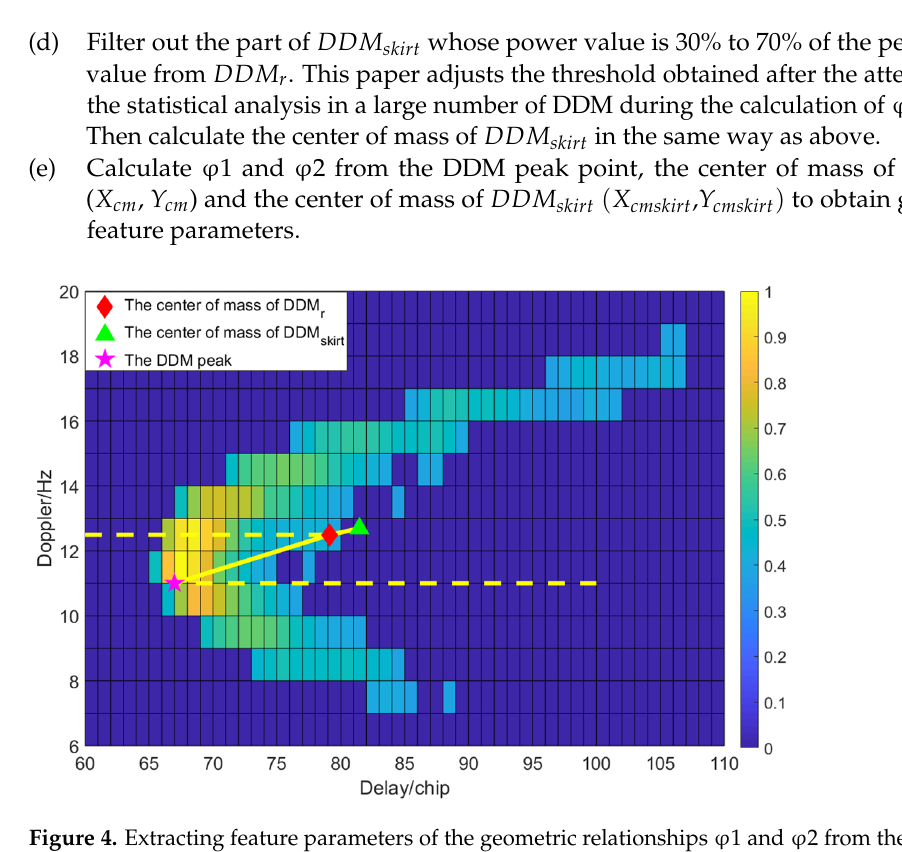
Figure 4. Extracting feature parameters of the geometric relationships φ 1 and φ 2 from the DDM of a 270° wind direction.